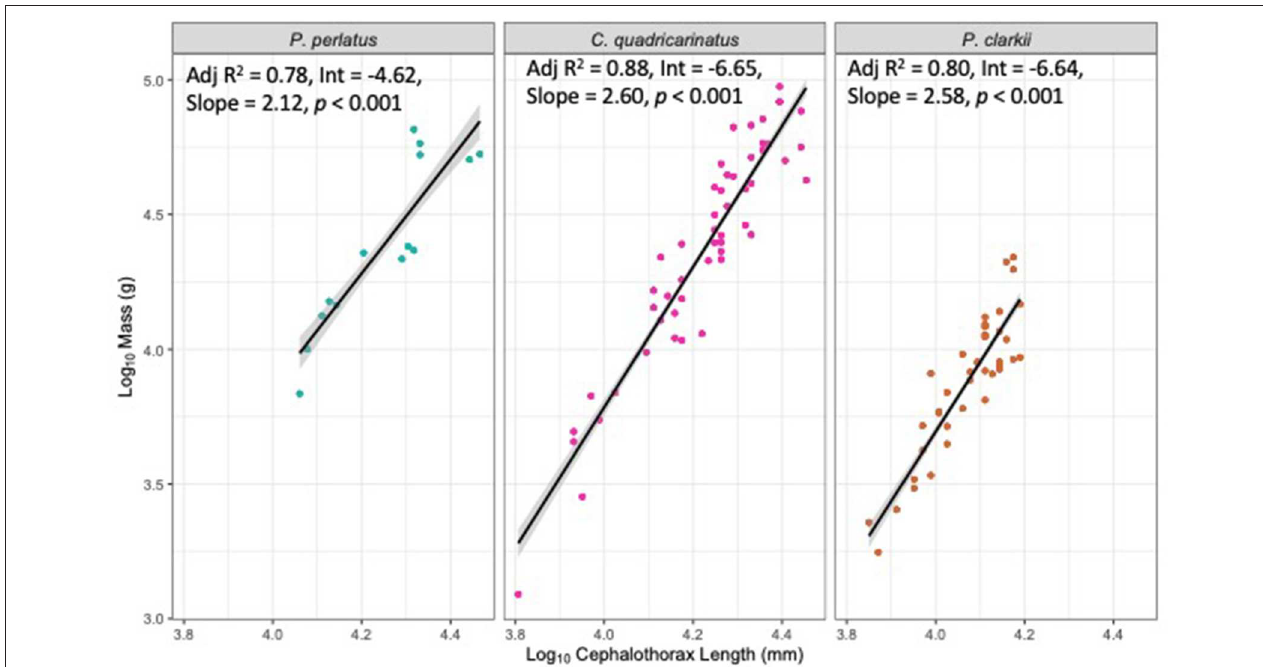
FIGURE 1 | Linear regressions and SE of Log 10 mass (g) and Log 10 Cephalothorax length (mm) of P. perlatus, C. quadricarinatus and P. clarkii .